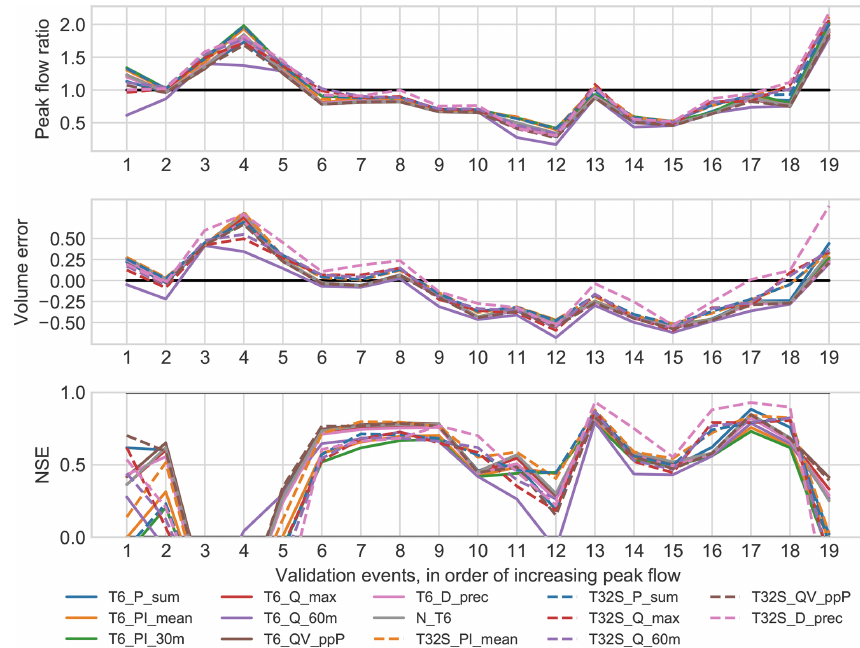
Figure 4. Error statistics for individual validation events for all calibration strategies in the HR